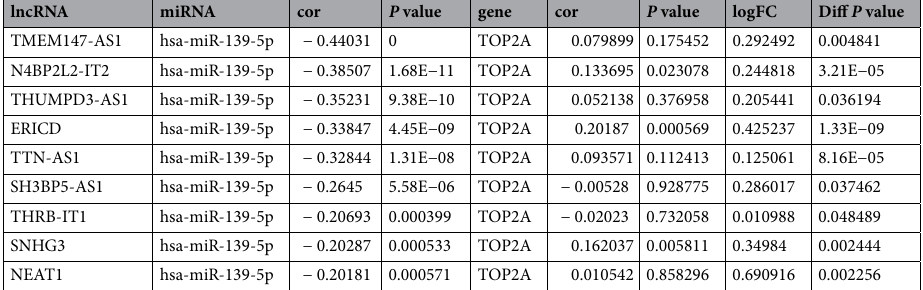
Table 2. The relationship between lncRNAs and miRNA-139-5p, lncRNAs and TOP2A, and the lncRnAs expression in KIRP and control tissues.